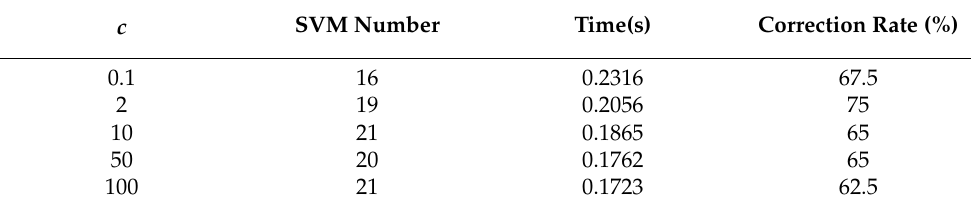
Table 2. Effect of penalty functions ( c ) on SVM bi-classifier